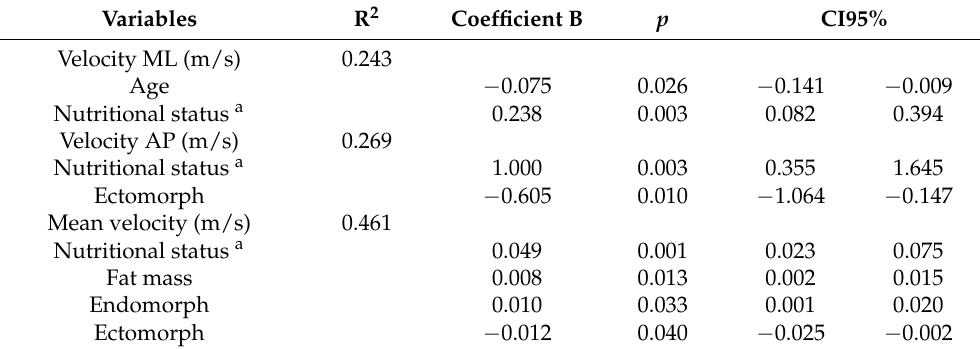
Table 4. Significant multiple linear regression models obtained for COP variables with eyes closed.